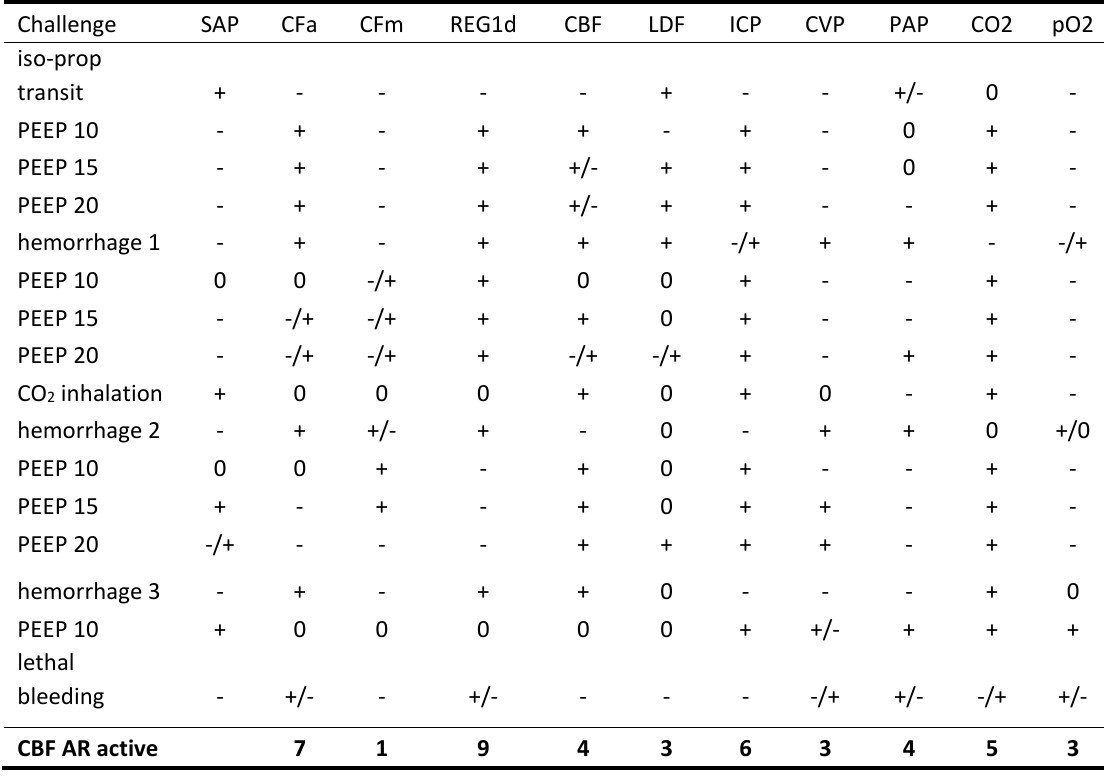
Table 1. Summary of CBF AR changes. Challenge